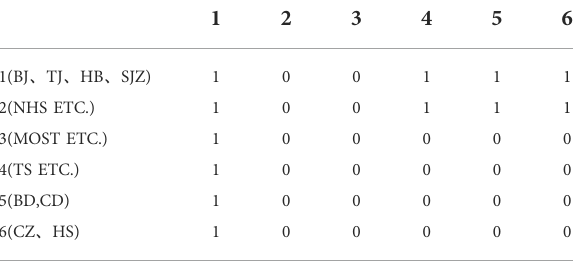
TABLE 6 Image matrix analysis of the ECSNs for COVID-19 in the B-T- H region.